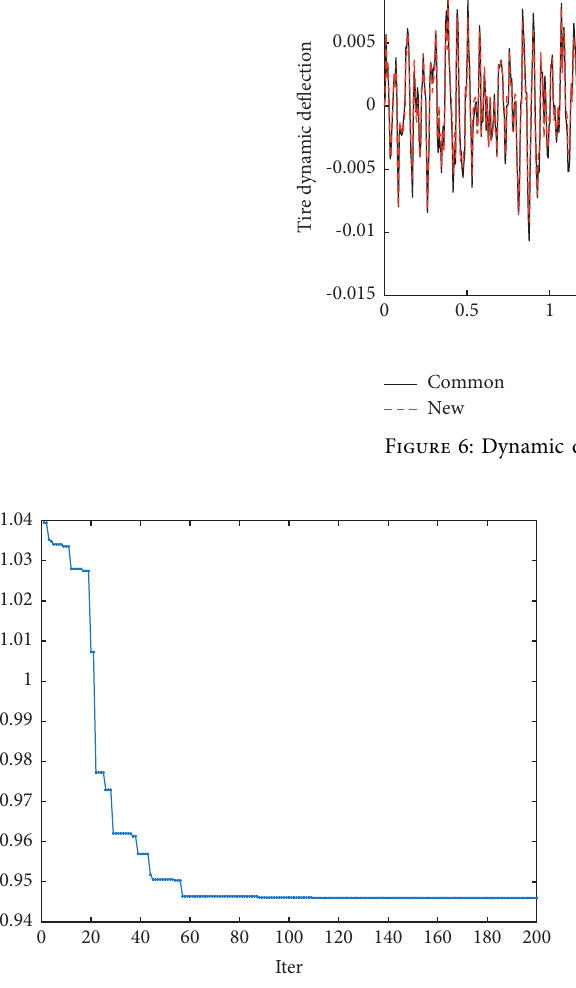
Figure 7: Fitness curve of